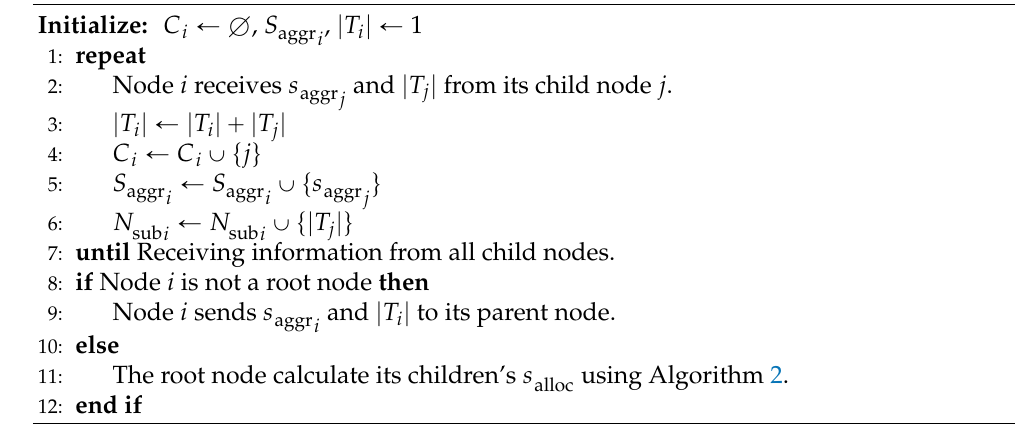
Algorithm 1 Collecting information of all nodes to their root